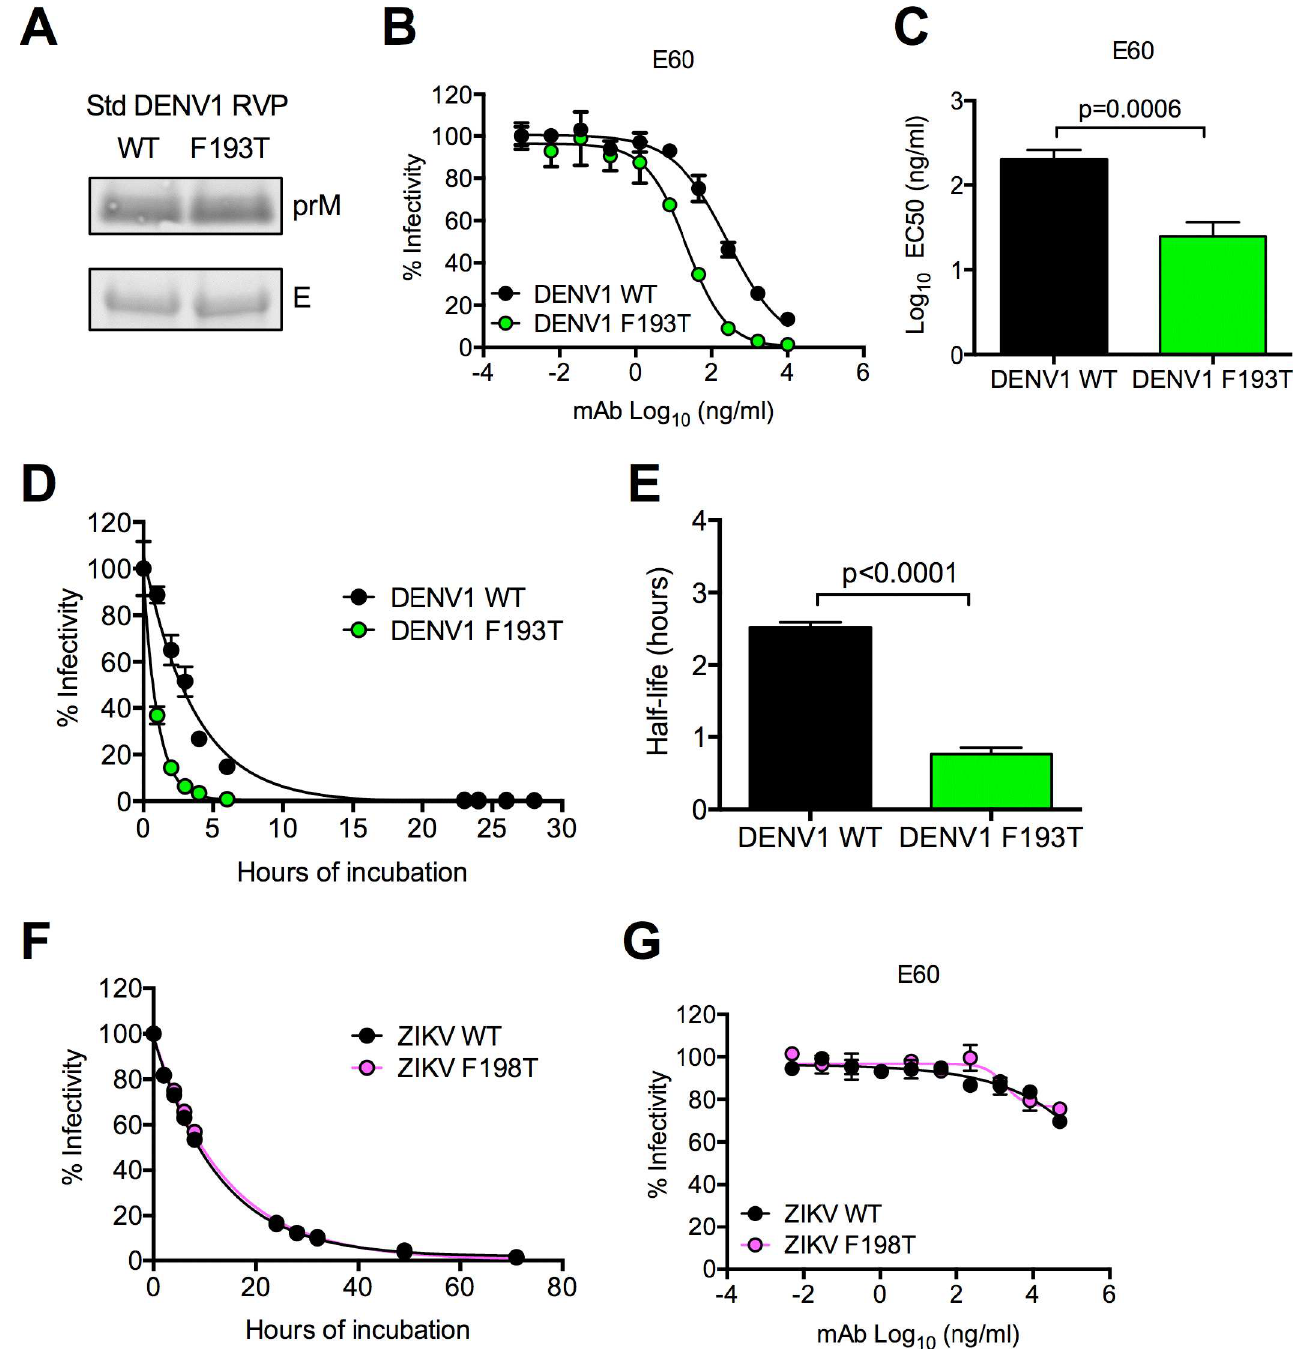
Fig 5. Characteristics of DENV1 E F193T and ZIKV E F198T RVPs. (A) We assessed the efficiency of prM cleavageof standard(Std) prepar- ations of WT andF193TDENV1RVPsby SDS-PAGE andWestern blottingof pelletedvirionsusinga mouseprM-reactivemAb(top panel).Thelevelof E protein,as detectedusingmousemAb 4G2, was usedas a loadingcontrol(bottom panel).Dataarerepresentative of threeindependent experiments performedusingindependent RVP preparations. (B) Representativedose-response neutralizationcurves for Std DENV1WT andF193T RVPsagainst mAb E60. Percent infectivityversusmAb concentrationis shown.Error bars indicatethe rangeof infectivityfrom duplicate infections. (C) Comparisonof meanEC50valuesof E60againstStd DENV1WT andF193T RVPsusinga pairedt-test. Valueswereobtainedfrom five independent experiments performedin duplicate. Error bars indicatetheSEM. (D) Representative intrinsicdecaycurvesof Std DENV1WT andF193T RVPs. Experiments were performedas describedin Fig 4A .Percentinfectivityversus hoursof incubationis shown.Errorbars indicatethe SEM obtainedfrom triplicateinfections of Raji-DC-SIGN-R cells. (E) Comparisonof the meanhalf-lifeof infectivityof Std DENV1WT andF193T RVPsusinga pairedt-test. Valueswere